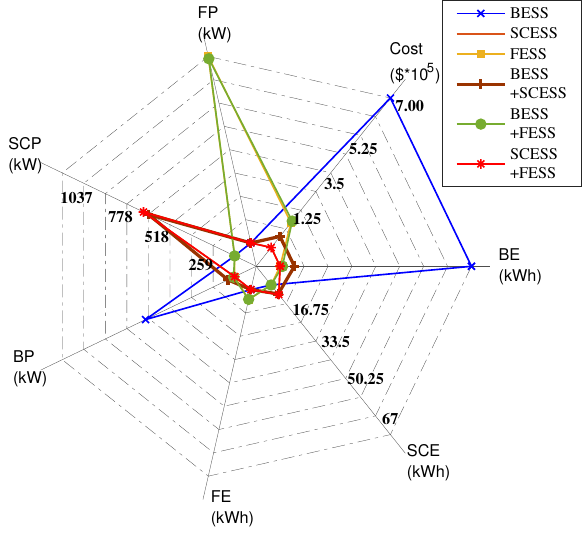
Figure 8. Comparison of different combinations of ESS for 15% regenerative energy saving, where BE: Battery Energy, BP: Battery Power, SCE: SC Energy, SCP: SC Power, FE: Flywheel Energy, FP: Flywheel Power. The axes for energy are scaled from 0–67 kWh, those for power are scaled from 0–1037 kW, and the axis for cost is scaled from $0.57 × 10 5 –7 × 10 5